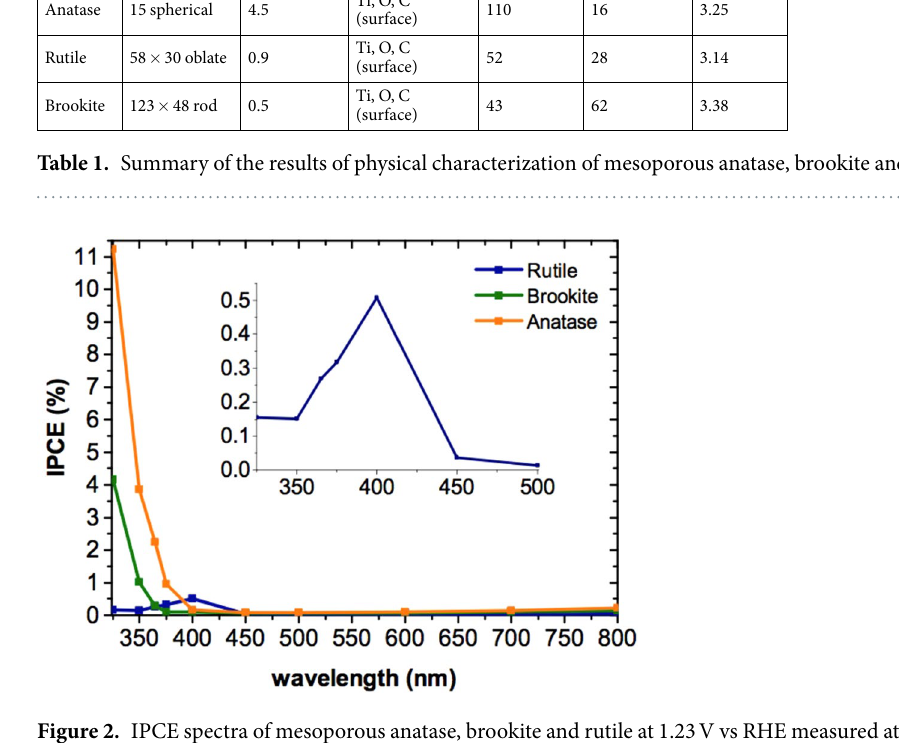
Figure 2. IPCE spectra of mesoporous anatase, brookite and rutile at 1.23 V vs RHE measured at pH 13.6 under front irradiation (semiconductor-electrolyte